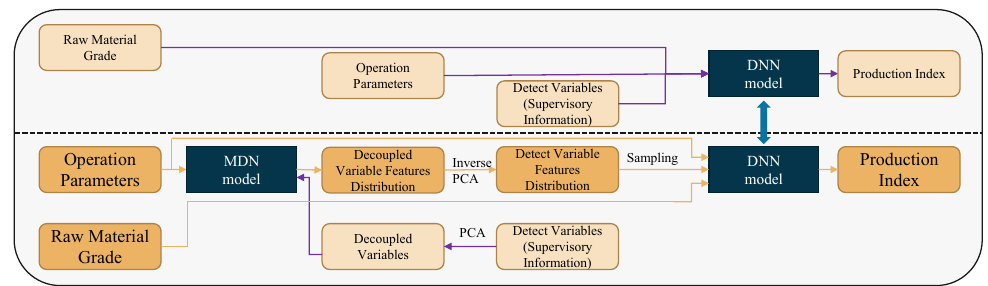
Figure 7. Illustration of a controllability assurance modeling